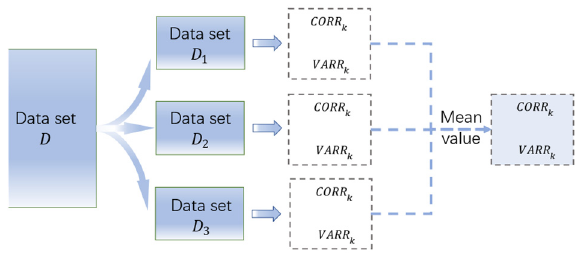
Figure 2. Splitting of dataset D and calculation.